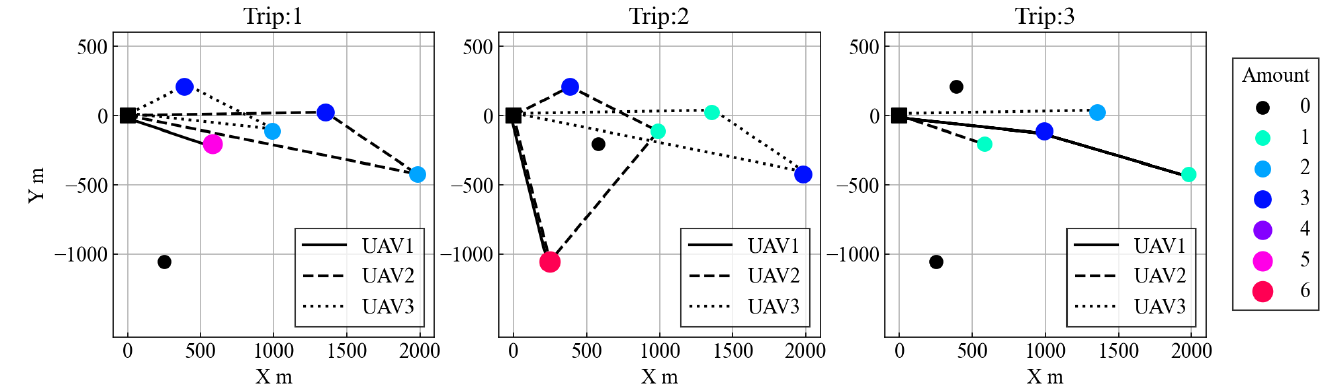
Figure 14. Route and resource allocation to minimize the objective value of Case 4 in Scenario 1. The lines represent the route of each UAV, and the color and size of the dots represent the amount of supplies supplied to each